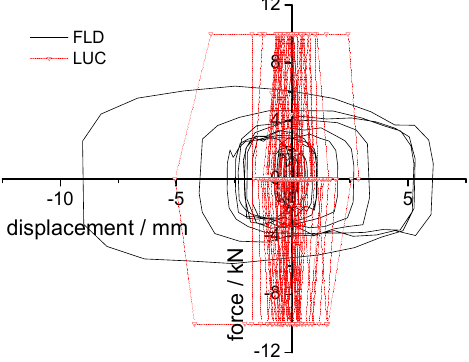
Figure 24. Comparison of the hysteretic curve between the lock-up clutch and the damper.